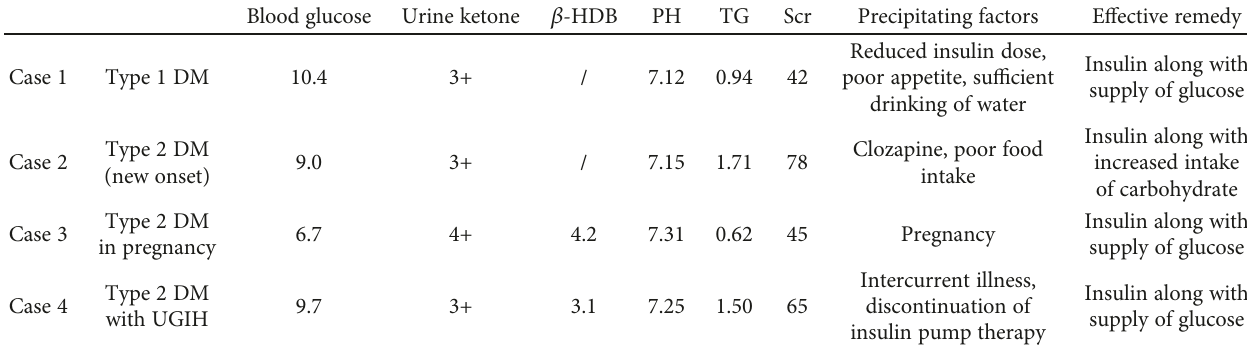
Table 1: Clinical features of 4 cases of EDKA.